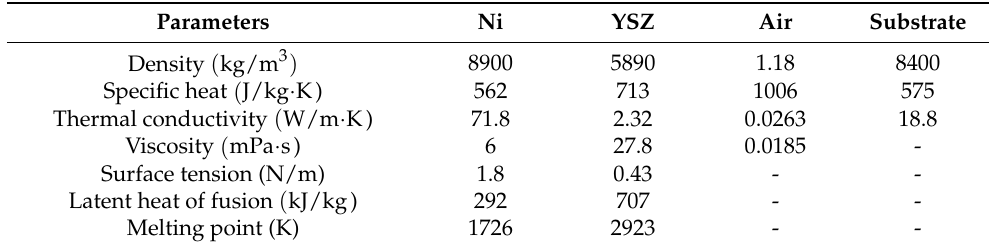
Table 1. Thermophysical parameters used in simulations.